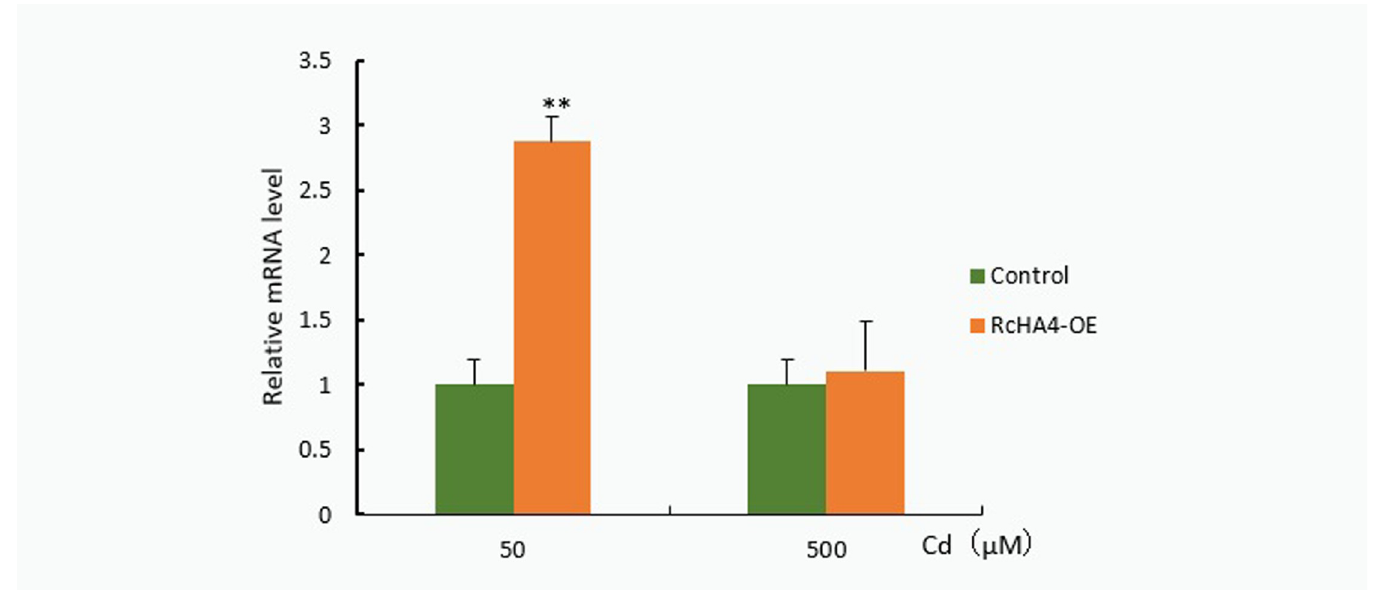
Fig 12. qRT-PCR analysis showed the expression of RcHA4 . Note: � : 0.01 < P � 0.05, �� : 0 < P � 0.01. https://doi.org/10.1371/journal.pone.0272750.g012 RcHA4 -OE were significantly better than those of Col-1 and Atha4 . At this Cd concentration, the degree and area of yellowing on the leaves of Atha4 increased, and the leaves of Col-1 began to appear chlorotic. When the Cd stress concentration was increased to 75 μ M, Col-1, Atha4 , and RcHA4 -OE were all seriously damaged. By comparing the length of the roots, the number of leaves and the degree of damage, RcHA4 -OE still appeared more resistant to Cd than Col-1, and Atha4 . Under Cd stress, the relative expression of RcHA4 in castor is up-regu- lated, indicating that castor plants enhance their tolerance to Cd stress by increasing the expression of RcHA4 . ATP-binding cassette (ABC) transporters, heavy metal transporting ATPase (HMAs) trans- porters and other proteins in response to heavy metal Cd stress through chelation have been